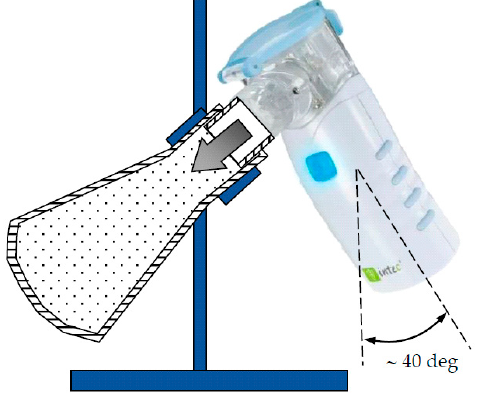
Figure 3. Scheme of the aerosol collection system.